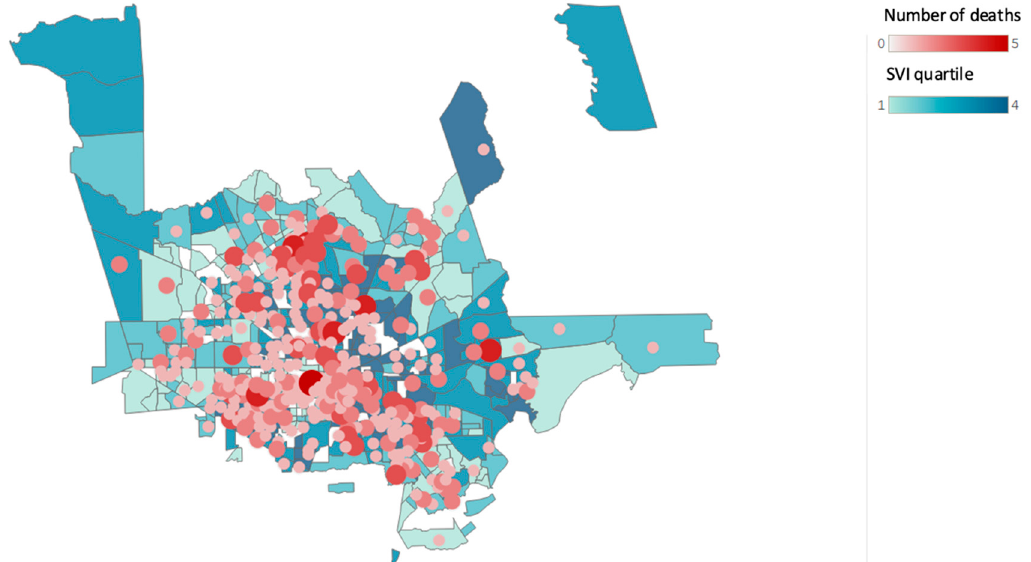
Figure 4. Non-hospital opioid-related overdose deaths by Social Vulnerability Index (SVI) according to census tract for the year 2021. (Source: Harris County Institute of Forensic Sciences, 2015–2021, U.S. Census Bureau; Centers for Disease Control and Prevention and the Agency for Toxic Substances and Disease Registry; and the U.S. Department of Housing and Urban Development Zip Code Crosswalk Files). The figure shows the total opioid-related overdose deaths based on the residential zip code counts to 567 for the year